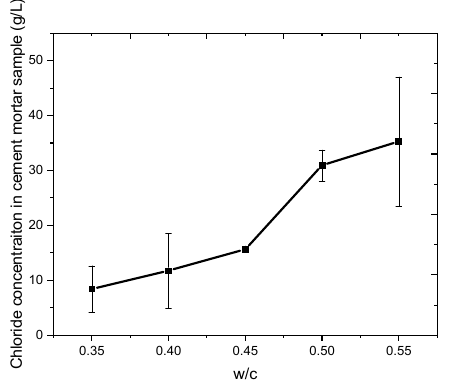
Figure 11. Chloride ion concentration in cement mortar sample.